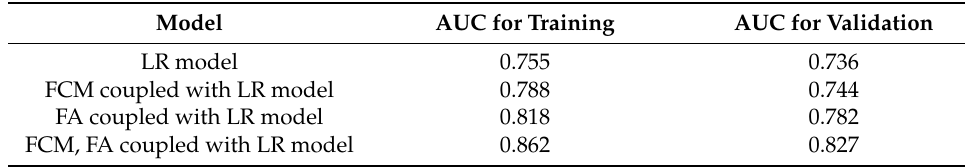
Figure 7. ROC cure for four models. ( a ) Success rate curve for training data; ( b ) prediction rate curve for validation data. Table 14. AUC values of models using validation data.